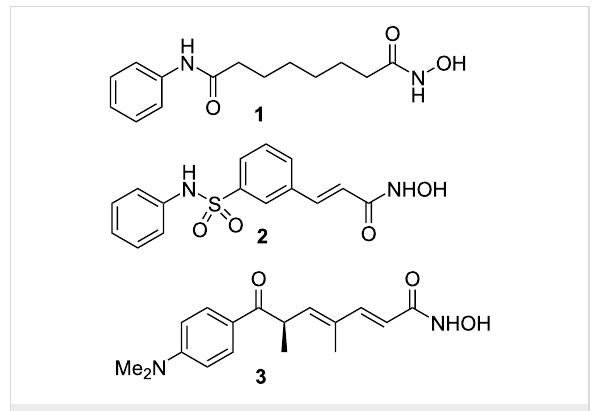
Figure 1: Some hydroxamic acid-based anti-tumor